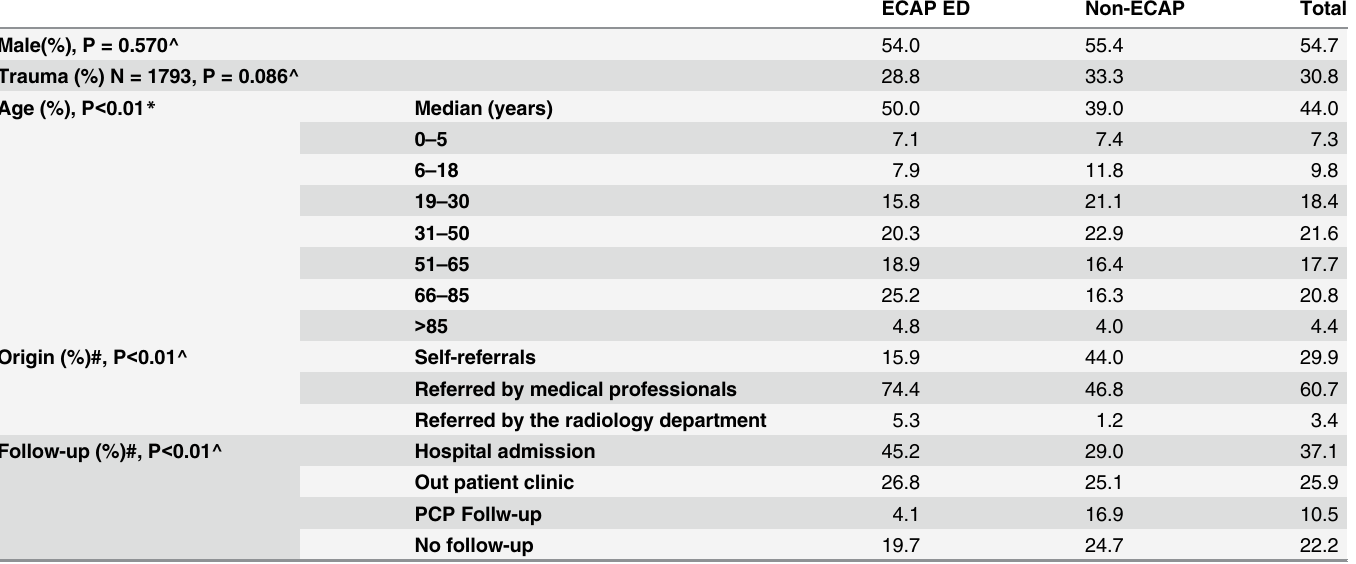
ECAP ED Non-ECAP Total